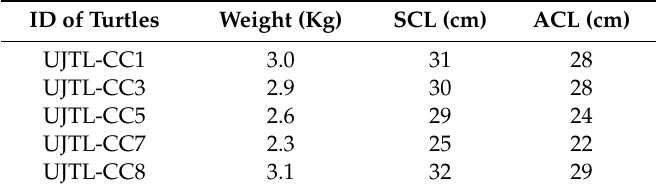
Table 1. Body size of the f specimens of loggerhead sea turtles sampled for erythrocytes, identification number, live weight, Straight Carapace Length (SCL), and Curved Cap Width (ACL).